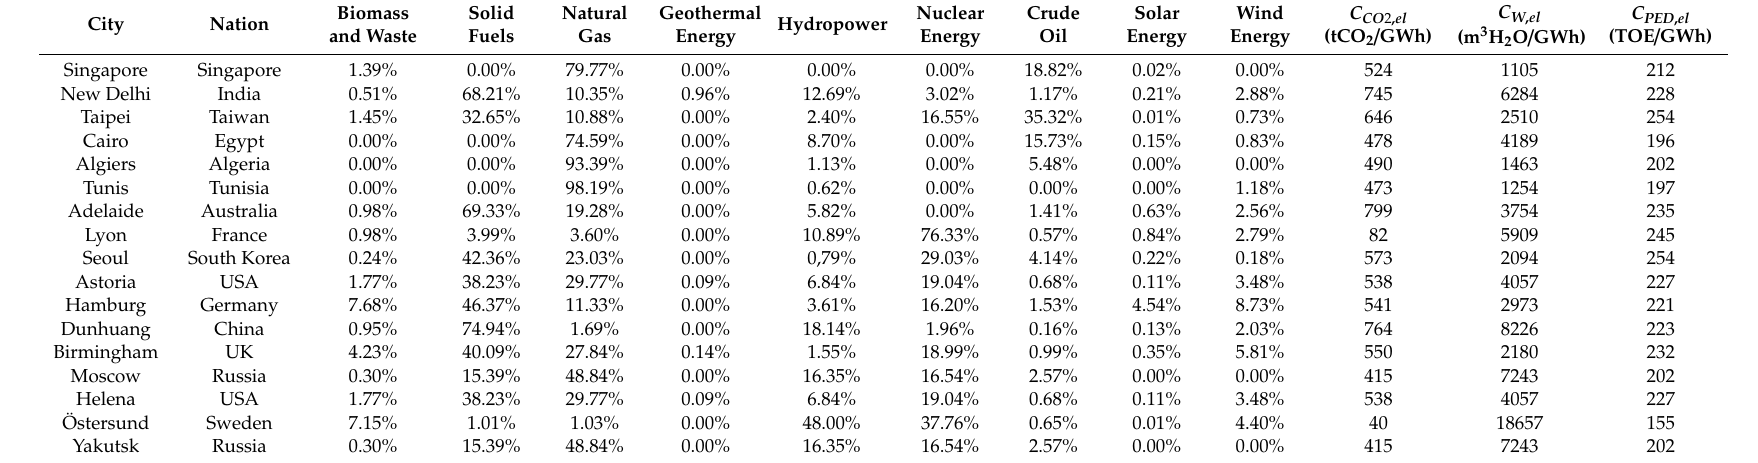
Table 2. National energy mix for the analysed countries (climates) in this paper [44]. TOE: ton (of) oil equivalent.